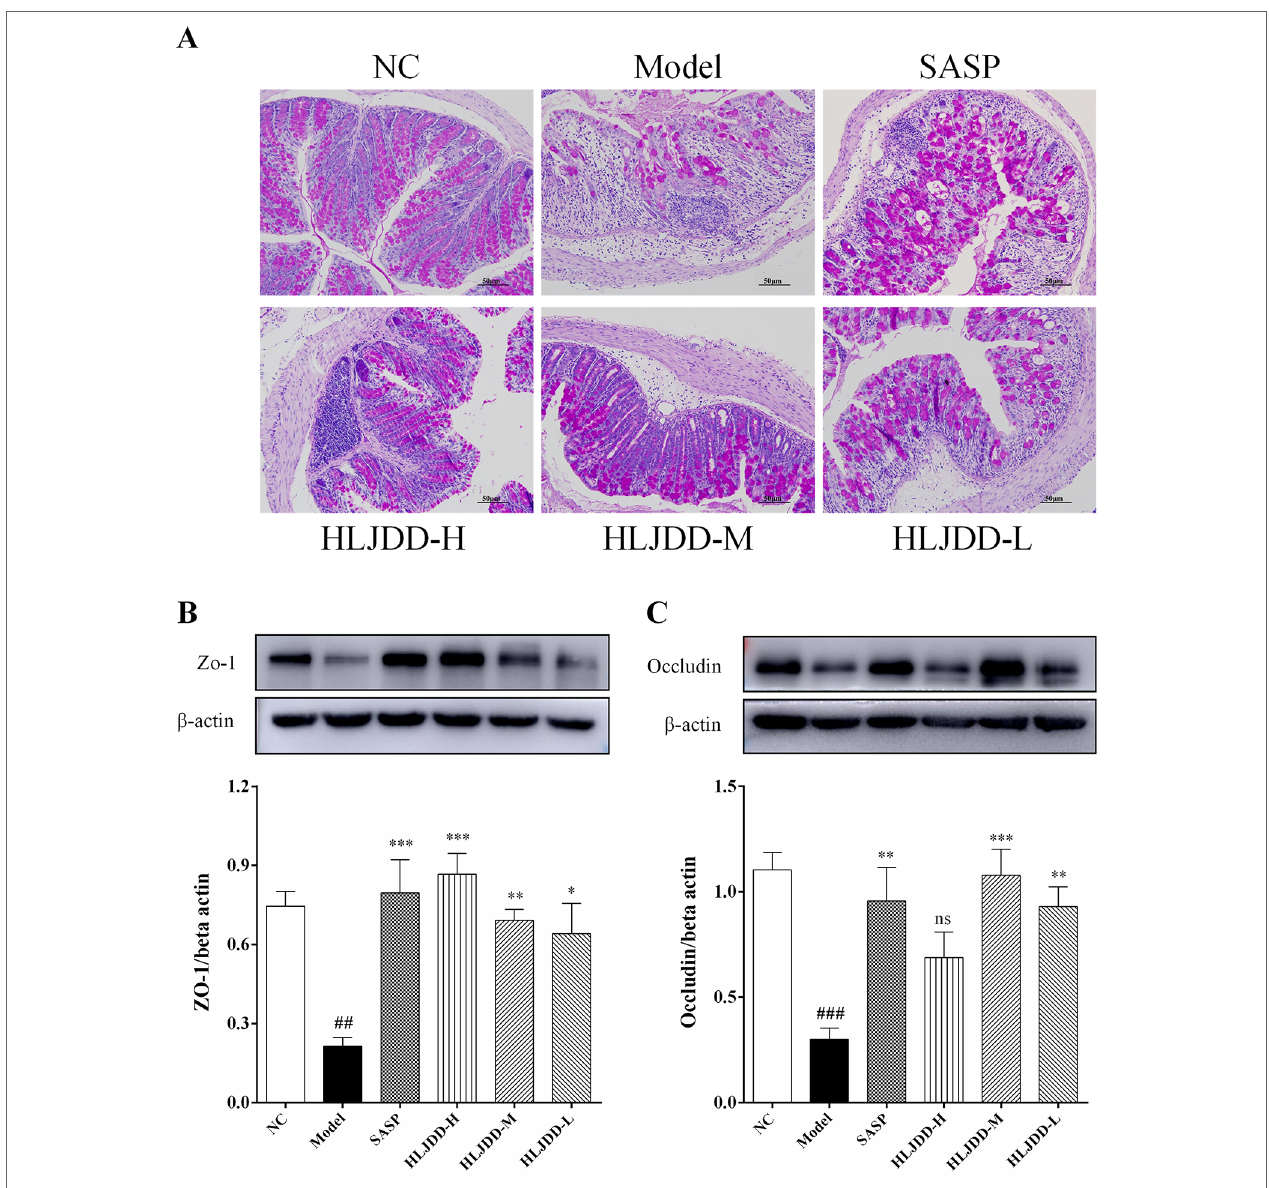
FIgURE 9 | The intestinal mucosal protective effect of HLJDD. (A) PAS staining of the colon tissue of different groups (200 × magnification). Western blot analysis of tight junction protein expression levels of ZO-1 (B) and Occludin (C) in colon tissue. Data are expressed as the mean ± SD, n = 5 per group. ## p < 0.01, ### p < 0.001 vs. NC group; * p < 0.05, ** p < 0.01, *** p < 0.001 vs. model group. ns, no